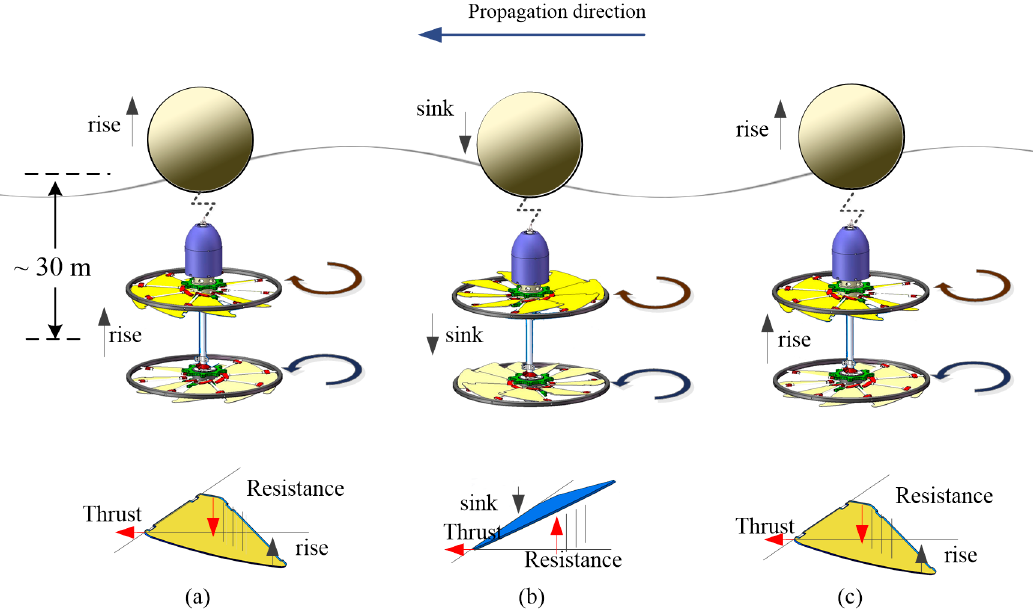
Figure 9. Working principle: ( a , c ) rising process; ( b ) sinking process.